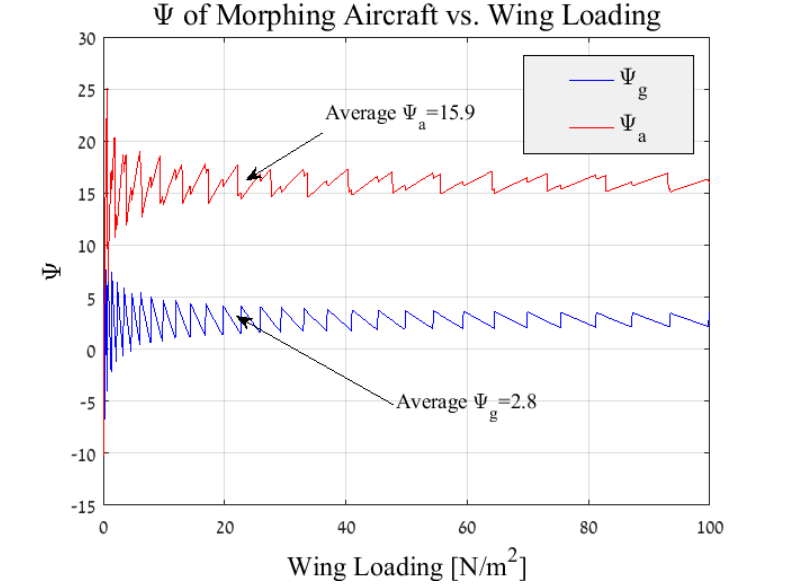
Figure 7. Morphing efficiency vs. wing loading at (cid:65) g = 8 and χ =